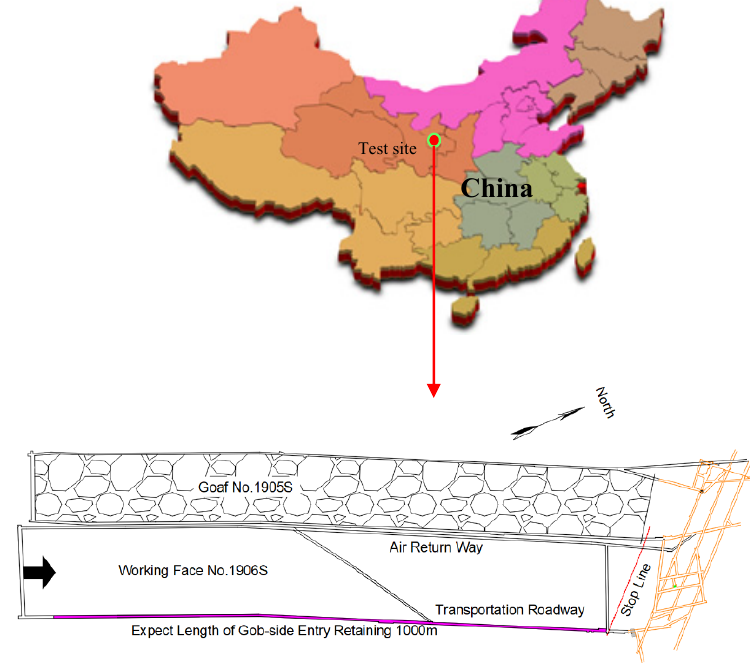
Figure 12. Fucheng Coal Mine location and plan view of 1906S working face layout.